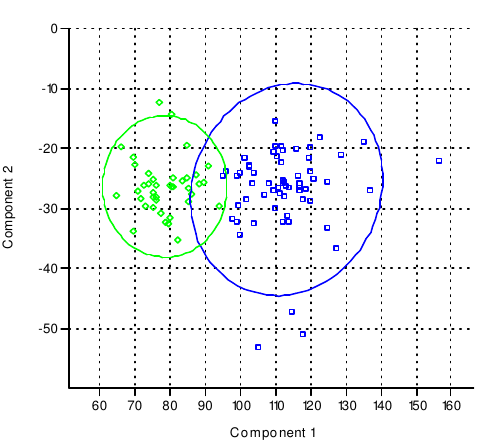
Fig. 6. Dendrogram showing similarity coefficient (95.2%) of the morphometrics of cultured male and female Clarias gariepinus employing the Bray-Curtis’s clustering algorithm *Pink color indicates male, green color indicates female